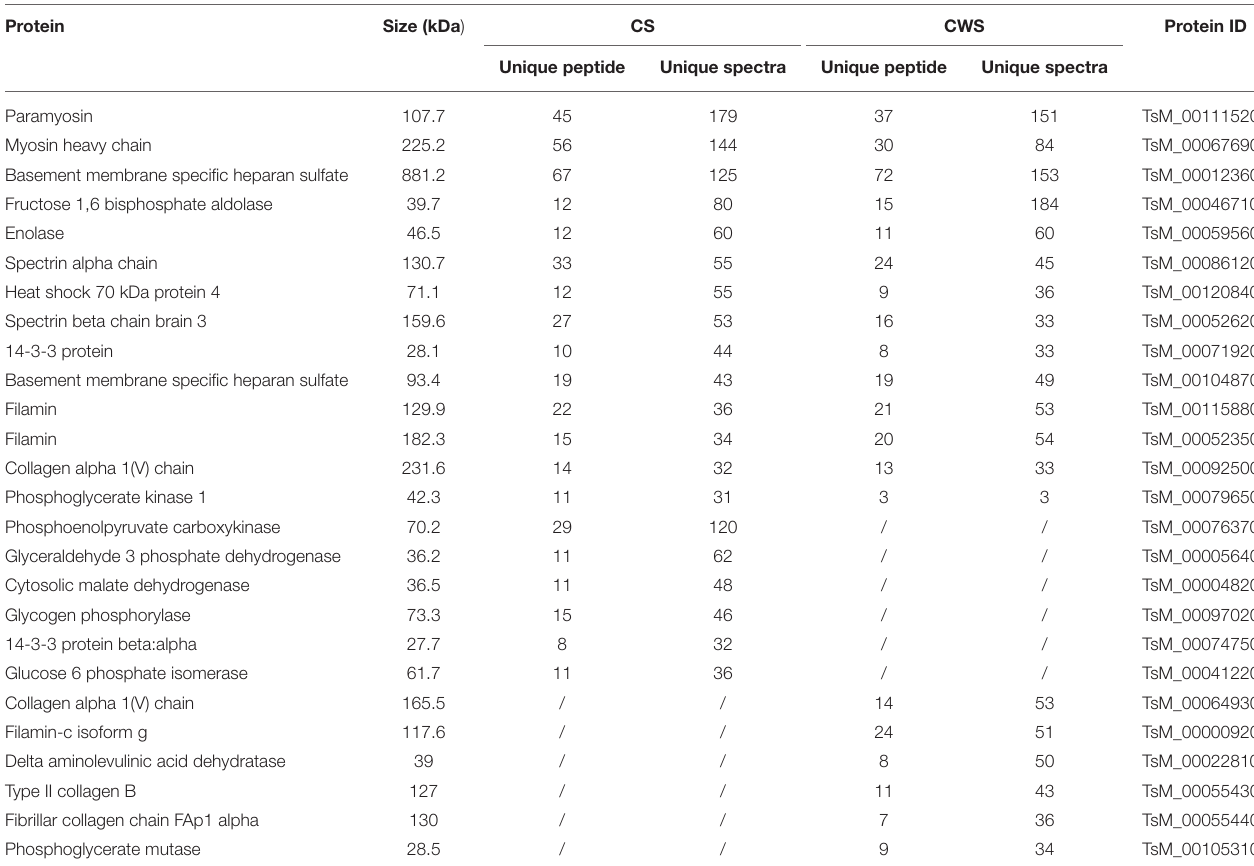
TABLE 1 | Top 20 proteins abundant in both CS and CWS. Protein Size (kDa ) CS CWS Protein ID Unique peptide Unique spectra Unique peptide Unique